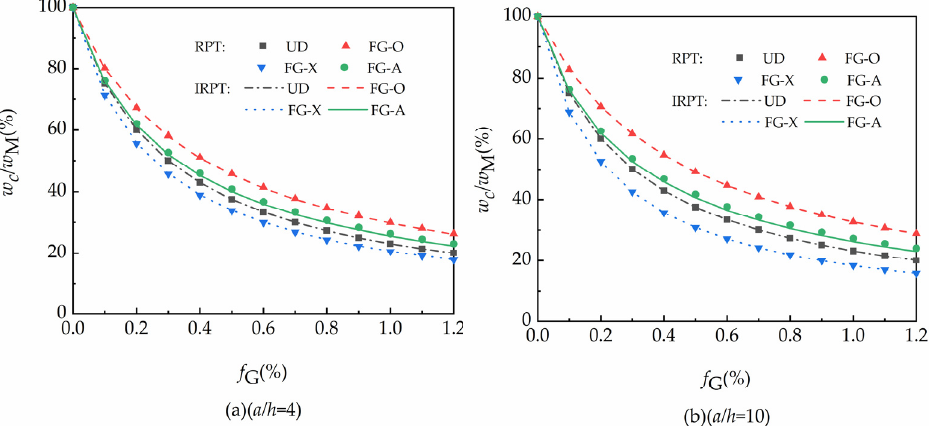
Figure 4. Effect of GPLs weight fraction f G on the deflection ratio w c / w M of FG-GRC plates under RPT and IRPT.